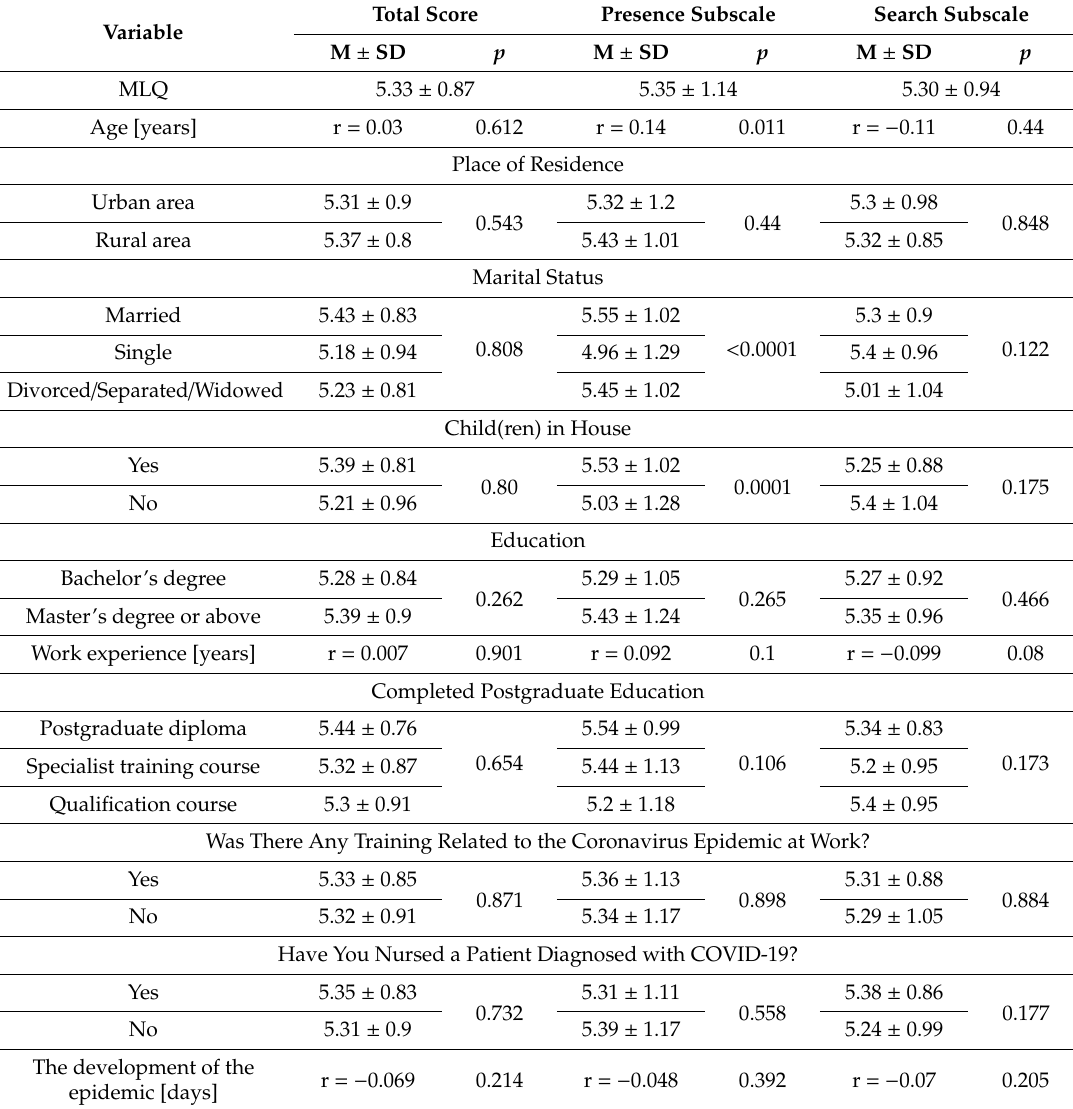
Key: The abbreviations correspond to the Table 2; MLQ: Meaning in Life